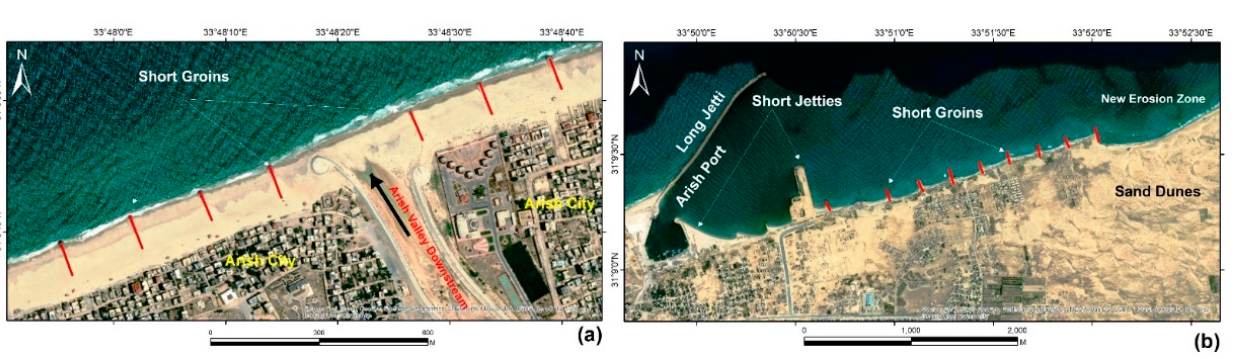
Figure 15. Coastal protection structures along the Arish Coast. ( a ) Al Arish Beach High Short Groins; ( b ) Al Arish Port Jetties and Short Groins.